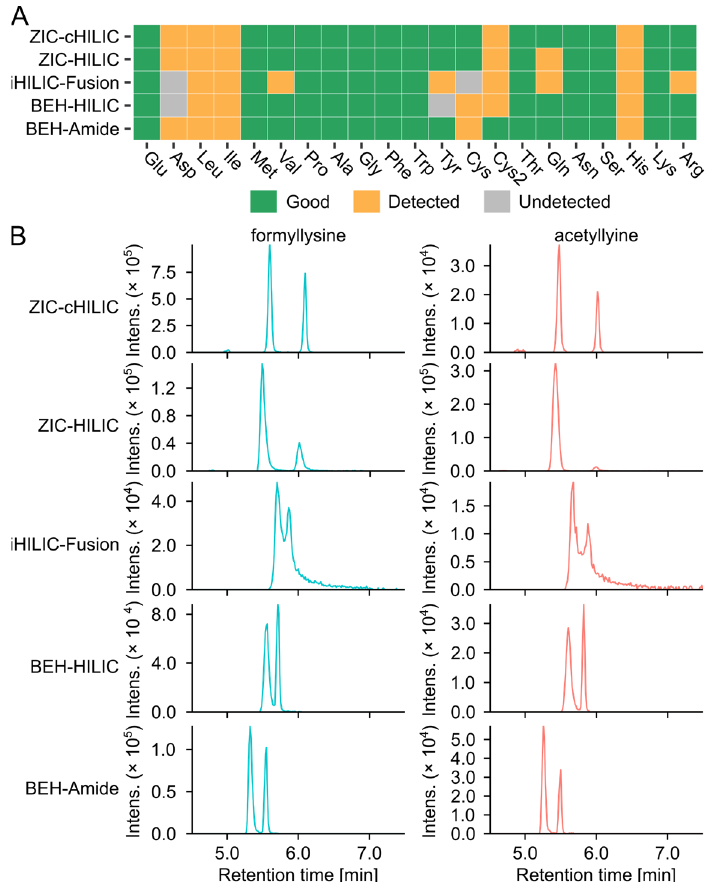
Figure 3. Targeted evaluation of column performance. ( A ) The individual score of amino acids analyzed by different HILIC columns. ( B ) Representative chromatograms of the putative advanced glycation end products isomers, formyllysine (C 7 H 14 N 2 O 3 , [M+H] + = 175.1077, blue) and acetyllysine (C 8 H 16 N 2 O 3 , [M + H] + = 189.1234, red), separated by different columns. EICs were extracted with ± 0.005